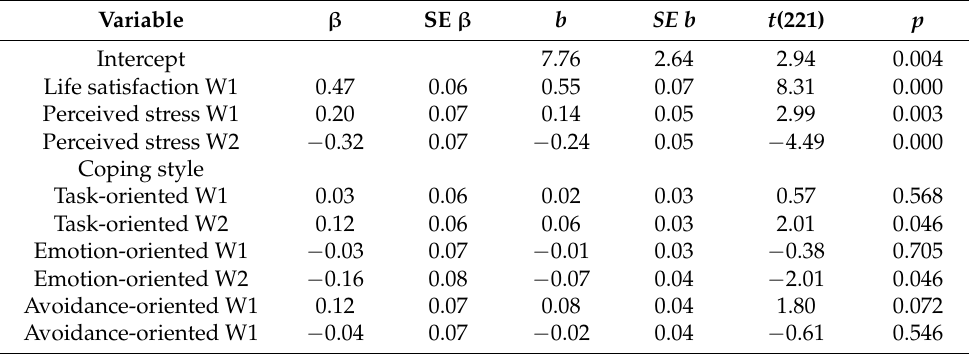
Table 4. Results of regression analysis for life satisfaction during the W2.